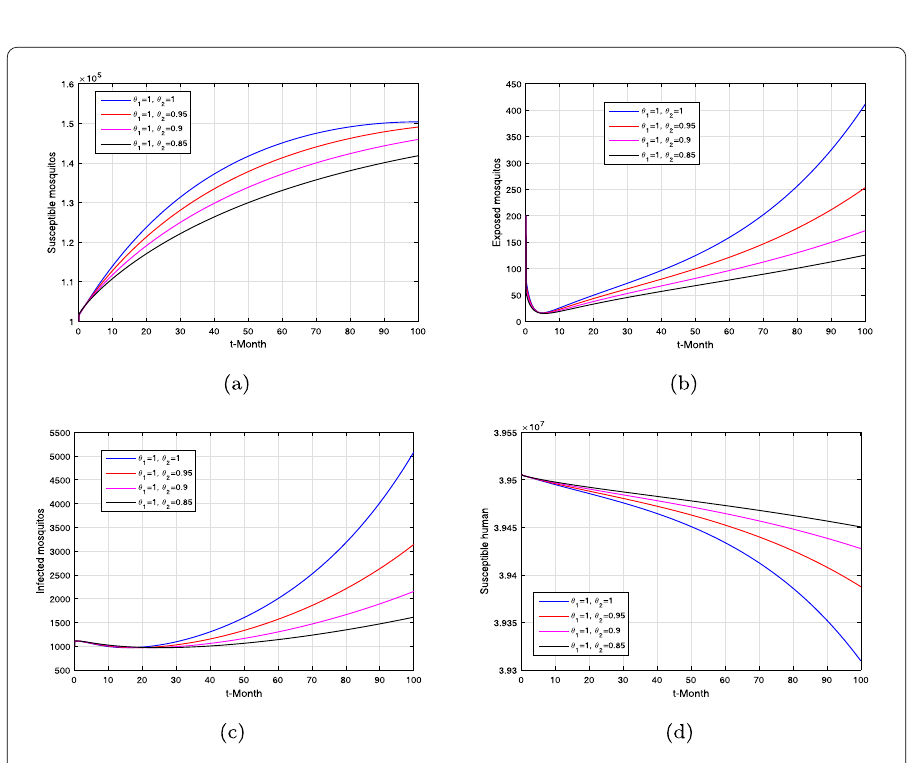
Figure 4 Simulation of the fractal-fractional model (10) when θ 2 = 1,0.95,0.9,0.85 and fractional order θ 1 = 1 where ( a ) susceptible mosquitos, ( b ) exposed mosquitos, ( c ) infected mosquitos, ( d ) susceptible